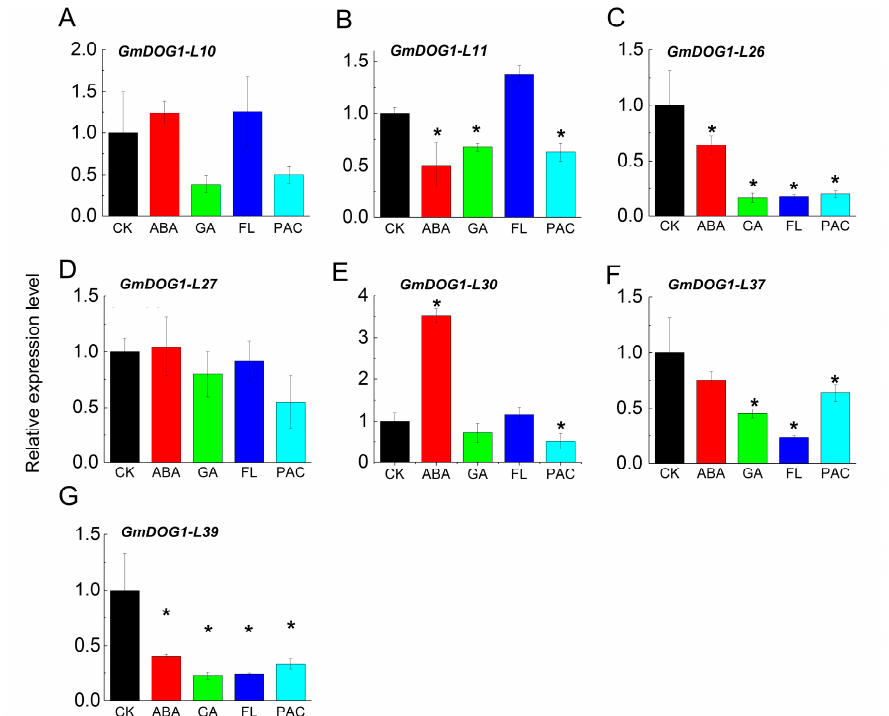
Figure 5. Expression profiles of GmDOG1Ls in soybean seeds after phytohormone treatment ( A – G ). Phytohormones include Abscisic Acid (ABA), Gibberellin (GA), FL and PAC, they all have a concentration of 5 μ mol/L. Expression levels of seven selected GmDOG1Ls were examined by qRT-PCR analysis. The housekeeping GmTubulin was used as an endogenous reference gene. The asterisk (*) indicates a significant difference at P < 0.05 by Student’s t-test analysis.